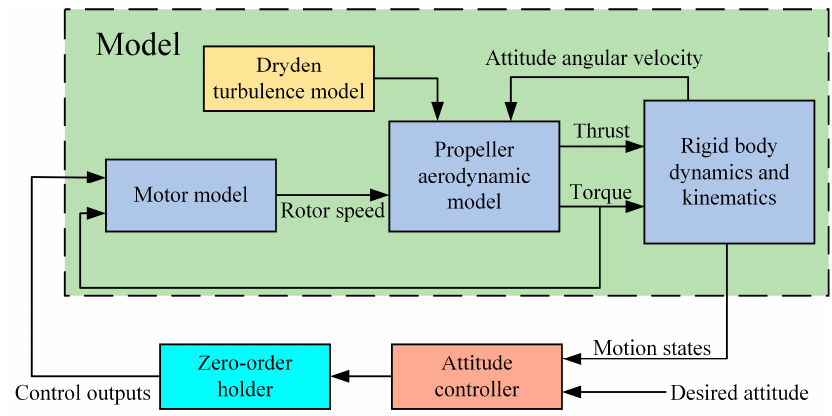
Figure 8. Structure of simulation model.